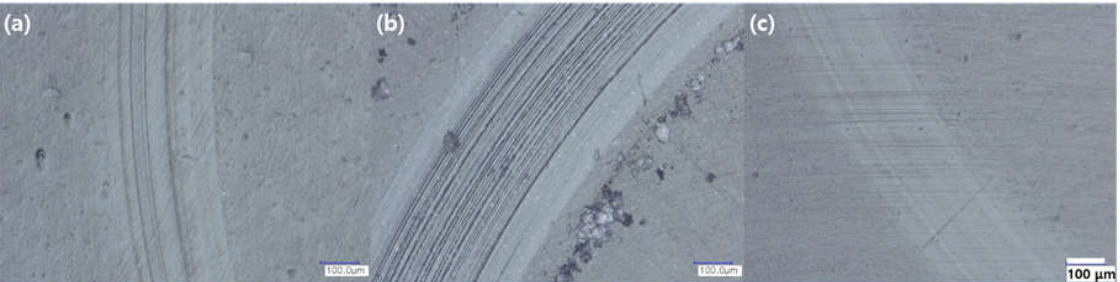
Figure 7. Optical micrographs of worn surfaces of ( a ) DH-10, ( b ) DR-10, and ( c ) S05-10 under friction condition (load: 10 N, sliding speed: 400 RPM, duration: 10